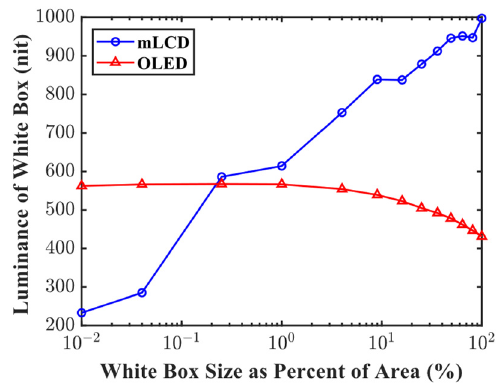
Figure 1. Luminance dependence on the APL.